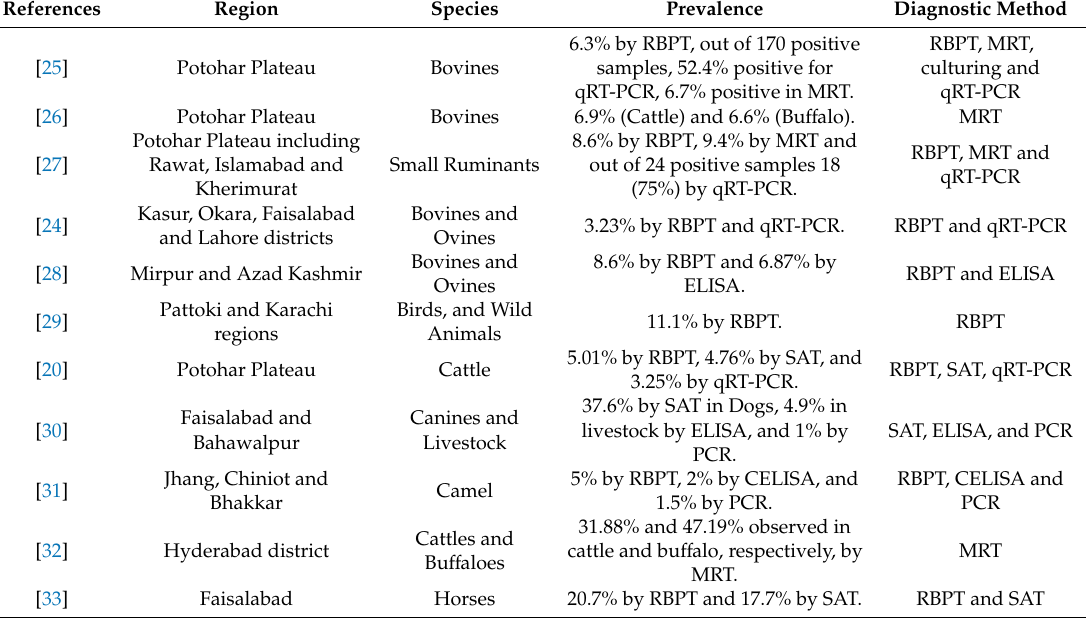
Table 5. Comparison of present and earlier studies conducted on brucellosis in di ff erent areas of